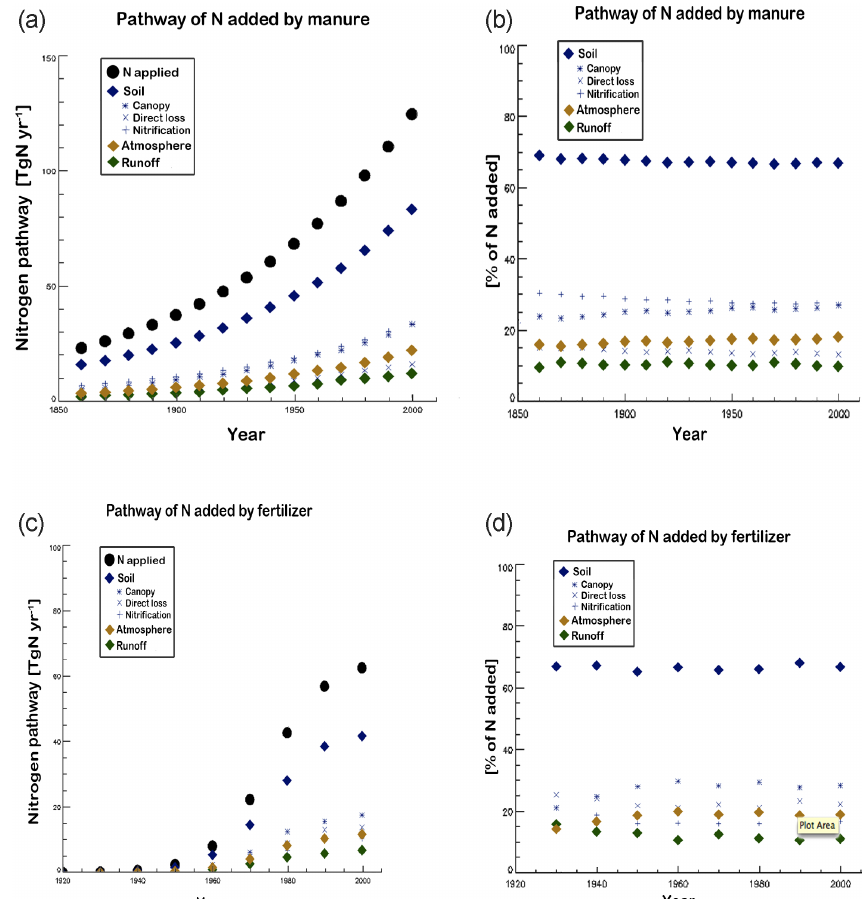
Figure 13. Applied nitrogen and nitrogen losses for the historical simulation inTgNyr − 1 for (a) manure and (c) synthetic fertilizer. Nitrogen losses from the TAN pool as a percentage of applied nitrogen for the historical simulation for (b) manure and (d) synthetic fertilizer. The losses from the TAN pool are divided into emission losses of ammonia to the atmosphere (gold diamond), runoff (green diamond) and loss to the soil. Loss to the soil is divided into that due to canopy loss (asterisk) (see Sect. 3.2.3), direct diffusive loss (cross) and nitrification